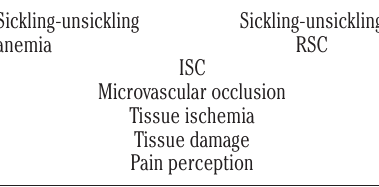
Table 1. Polymerization of deoxy-Hb. 14 Sickling-unsickling Sickling-unsickling anemia RSC